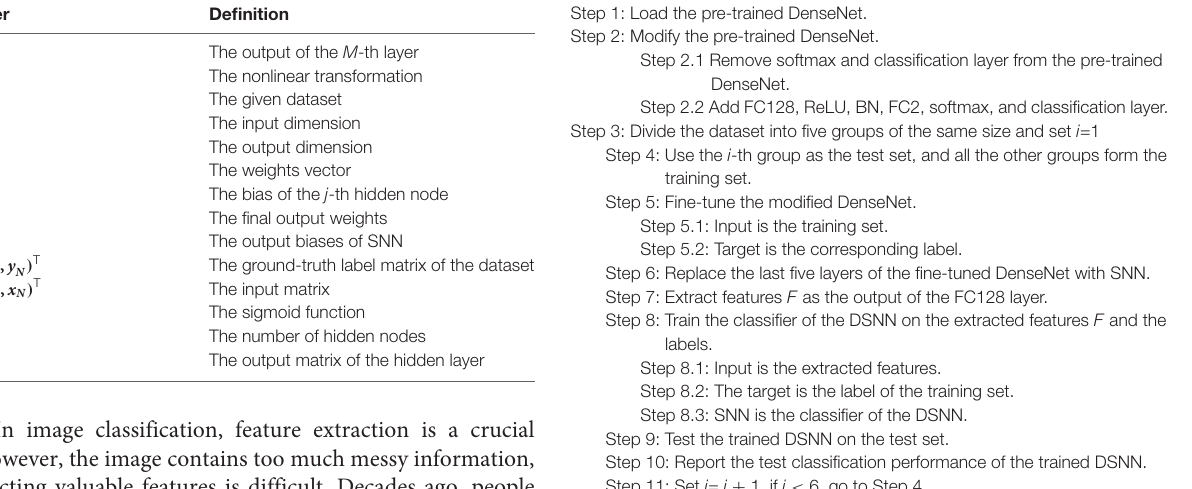
TABLE 3 | The definition of the parameter. Parameter Definition